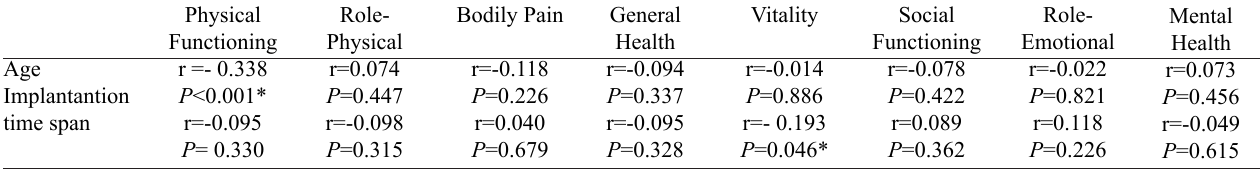
Table 5. Pearson correlation coefficient and P value between score values of SF-36 questionnaire domains and the variables: age and implantation time